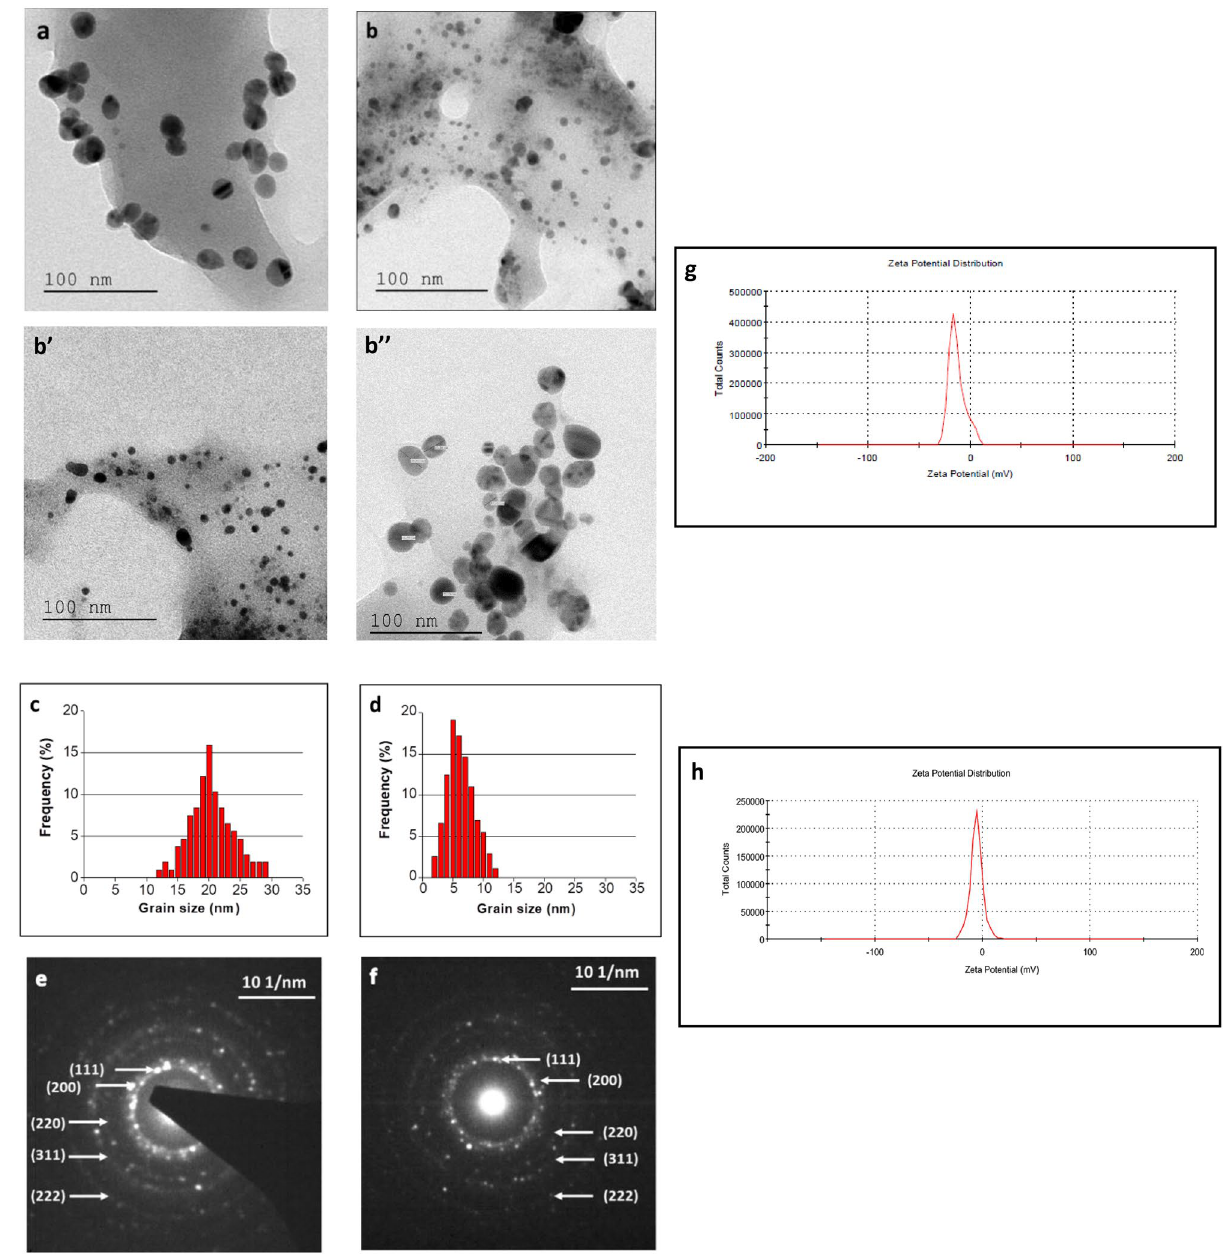
Figure 2. Biosynthesis of AgNPs. Scanning electron micrograph of AgNPs formed in (a) control culture supernatant and in supernatant of culture grown in presence of (b,b’,b’’) 250mT SMF. Histograms of AgNP average diameter size formed in (c) control culture supernatant and in supernatant of culture grown in presence of (d) 250mT SMF. Selected-area electron diffraction (SAED) patterns for AgNPS from (e) control and (f) SMF culture supernatants. Zeta potential of AgNPs formed in (g) control culture supernatant and in supernatant of culture grown in presence of (h) 250mT Concentric rings with intermittent bright dots were evident in SAED, indicating a high degree of crystallinity (Fig. 2e,f). The lattice constant calculated from this pattern was a = 4.087 Å, which agrees well with the reported value of 4.086 Å 18 . A fringe spacing of 0.23 nm was measured between lattice planes and is in accordance with the (1 1 1) lattice spacing of face-centered cubic (fcc) silver (d1 1 1 = 0.2359 nm). Average particle diameters of AgNPs were calculated from X-ray diffraction using the Debye–Scherrer equation 26 as 18 nm (control) and 6 nm (SMF), respectively (Fig. 2a,b). These values agree well with those from TEM (Fig. 2c,d). Crystallinity of the biosynthesized nanoparticles was evaluated using X-ray diffraction (XRD). Patterns presented in Fig. 3 show several Bragg reflections with various 2θ values depending on the AgNPs batches. Nevertheless, both AgNPs formulations exhibited three diffraction peaks (marked with asterisks in Fig. 3a,b), at 2θ: 38.28°, 44.33° and 64.33°, which correspond to the Bragg reflections of (111), (200) and (220) planes of